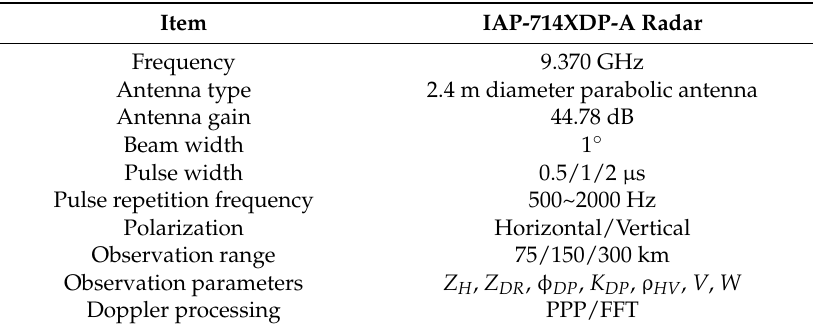
Table 1. System Characteristics of the IAP-714XDP-A